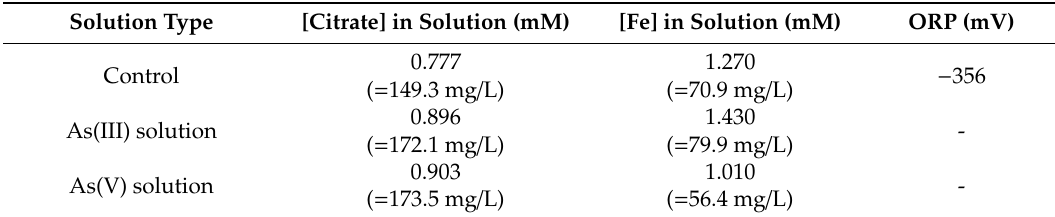
Figure 9. X-ray photoelectron spectroscopy (XPS) survey spectra for the CF-NC samples before and after arsenic (III and V) sorption. Table 5. Solution chemistry after reaction with CF-NCs.